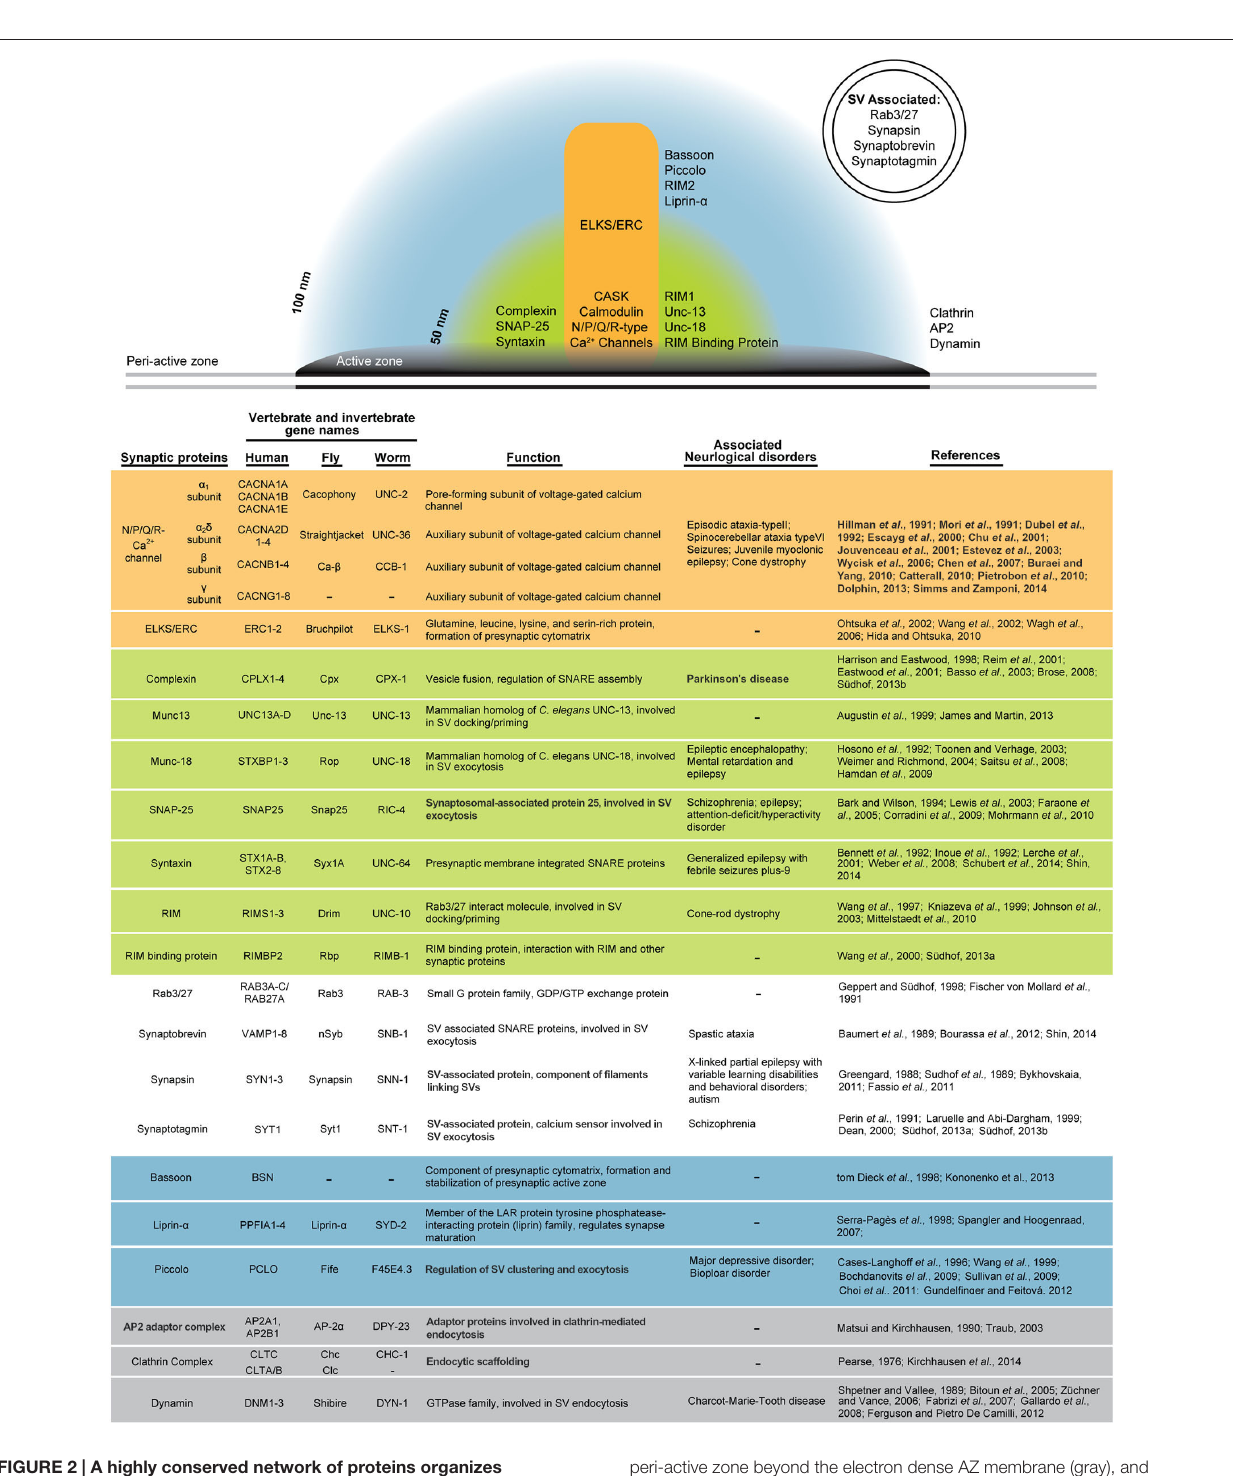
FIGURE 2 | A highly conserved network of proteins organizes presynaptic function . Presynaptic proteins can be grouped into zones within the AZ based on studies of their location. Although the structural complexity of the presynapse is not illustrated (see Figure 1 ), it can be generally divided into the dense projection (orange), an AZ-proximal zone extending to approximately 50 nm from the membrane (green), an AZ-distal zone extending to approximately 100 nm from the membrane (blue), the